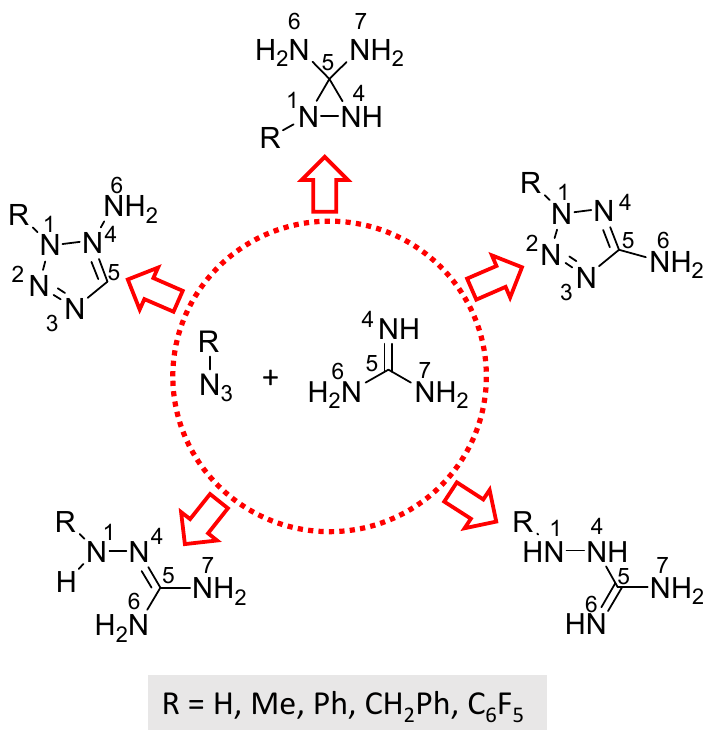
Figure 1. Model reaction system and possible products.